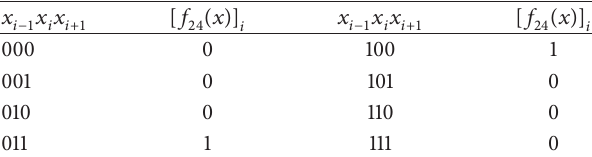
Table 1: The truth table of Boolean function of rule 24. 𝑥 𝑥 𝑥 𝑖−1 𝑖